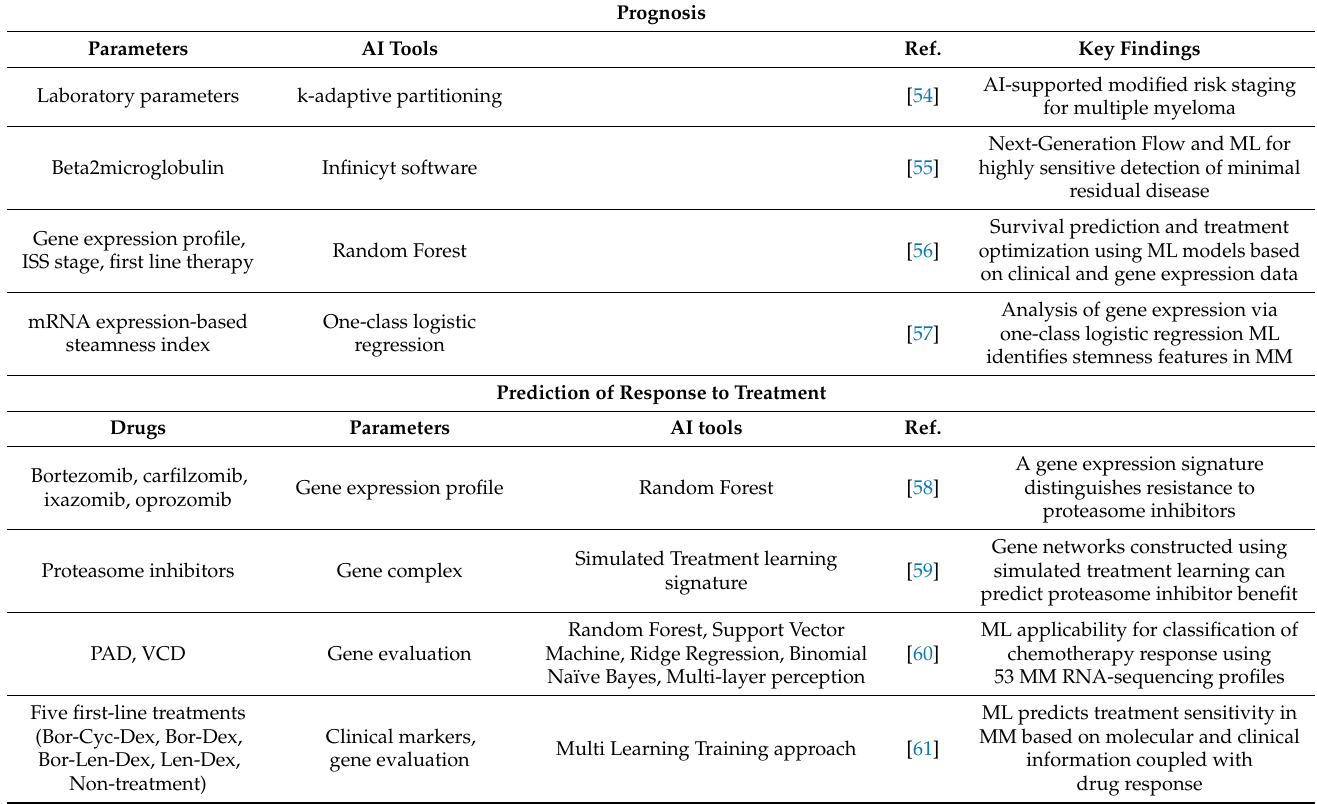
Table 2. Artificial intelligence (AI) applications in multiple myeloma prognosis and prediction of response to